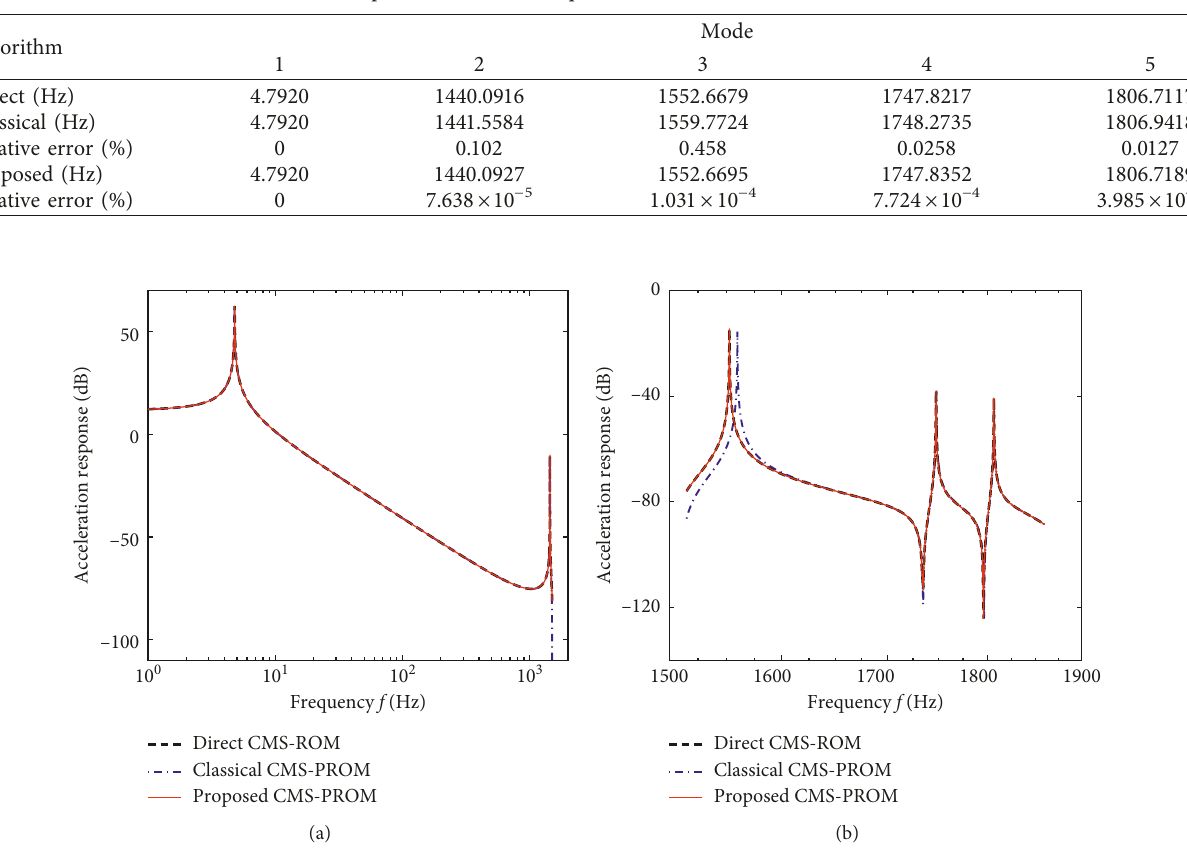
Figure 6: Comparison of online calculation time between the classical CMS-PROM and the proposed CMS-PROM. Table 1: Comparison of nature frequencies between different CMS ROMs.